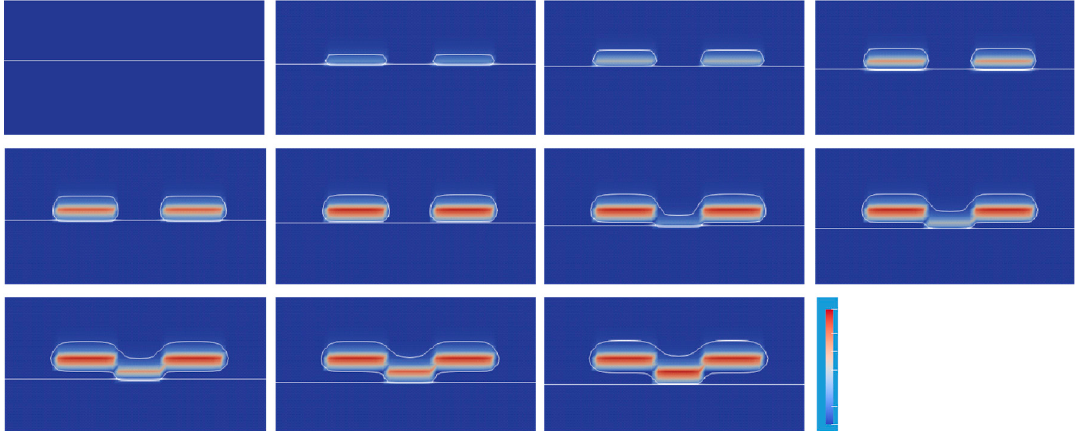
Figure 8. Contour plot of normalized oxygen concentration of 0.9 and C=C bond conversion distribution at a lift-up speed of 0.1 mm/s and alternating UV light position with UV absorber.